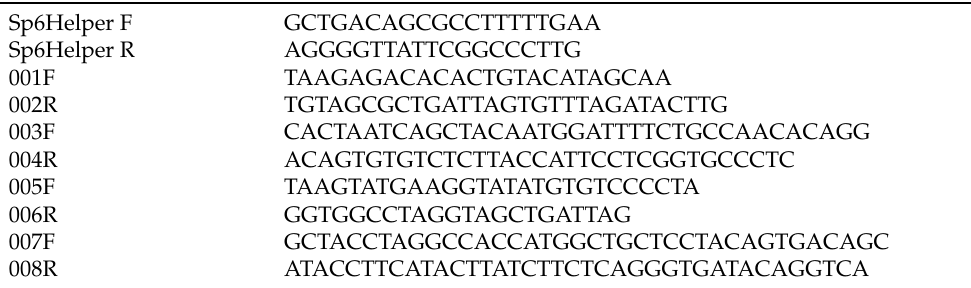
Table 1. List of primers used to exchange E3-E2-6K-E1 cassette in pChikHelper-E or the C gene in pChikHelper-C against the corresponding codon optimized sequences of